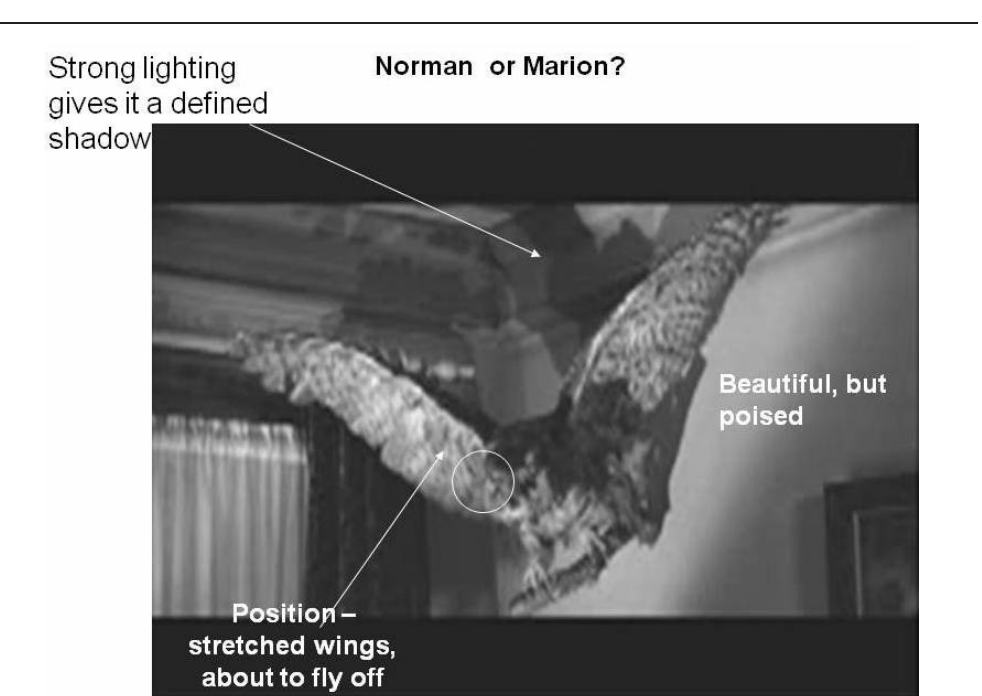
Figure 2: Slide from a 13-year-old student’s PowerPoint ‘essay’ on